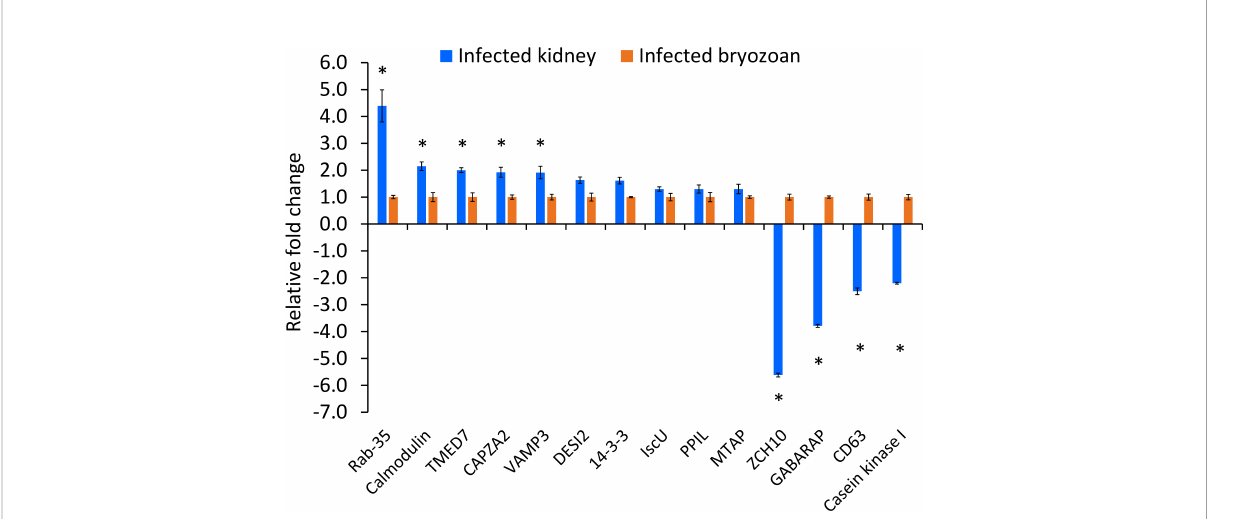
FIGURE 5 Relative expression of Tetracapsuloides bryosalmonae in vivo -induced genes. Assessment of expression of IVI genes in infected kidney of brown trout compared to their expression in infected bryozoan. qRT-PCR data were normalized with reference genes, and represented as a fold change relative to infected bryozoan expression levels. Signi fi cant differences (p < 0.05) between infected kidney and infected bryozoan of each gene are indicated with an asterisk (*). Error bars represent the standard error (n = 6). TMED7, Transmembrane emp24 domain-containing protein 7; CAPZA2, F-actin-capping protein subunit alpha-2; VAMP3, Vesicle-associated membrane protein 3; ZCH10, zinc fi nger CCHC domain-containing protein 10; GABARAP, gamma-aminobutyric acid receptor-associated protein; DESI, desumoylating isopeptidase 2; IscU, iron-sulfur cluster assembly scaffold protein; PPIL, peptidyl-prolyl cis-trans isomerase; MTAP, S-methyl-5 ’ -thioadenosine